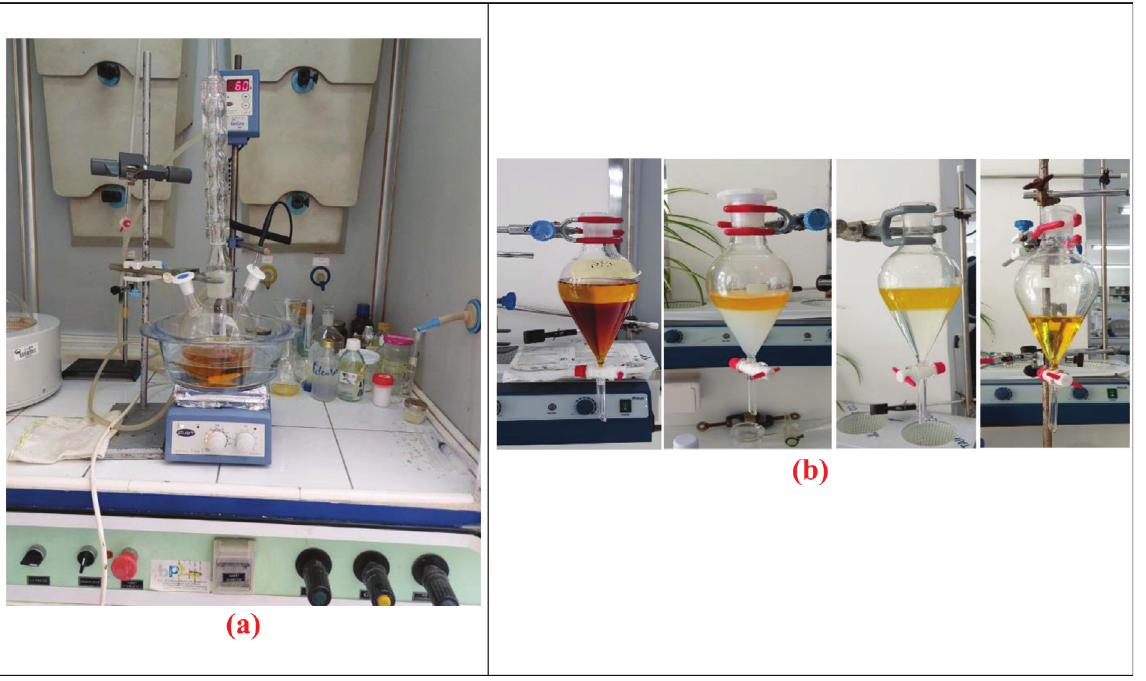
Fig. 1. (a) Experimental reactor for biodiesel production. (b) Biodiesel and glycerol separation phases and puri fi cation by successive washings.